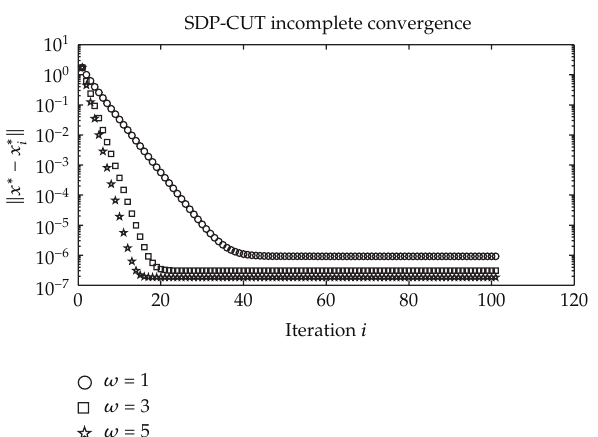
Figure 16: The “leveling o ff ” e ff ect.